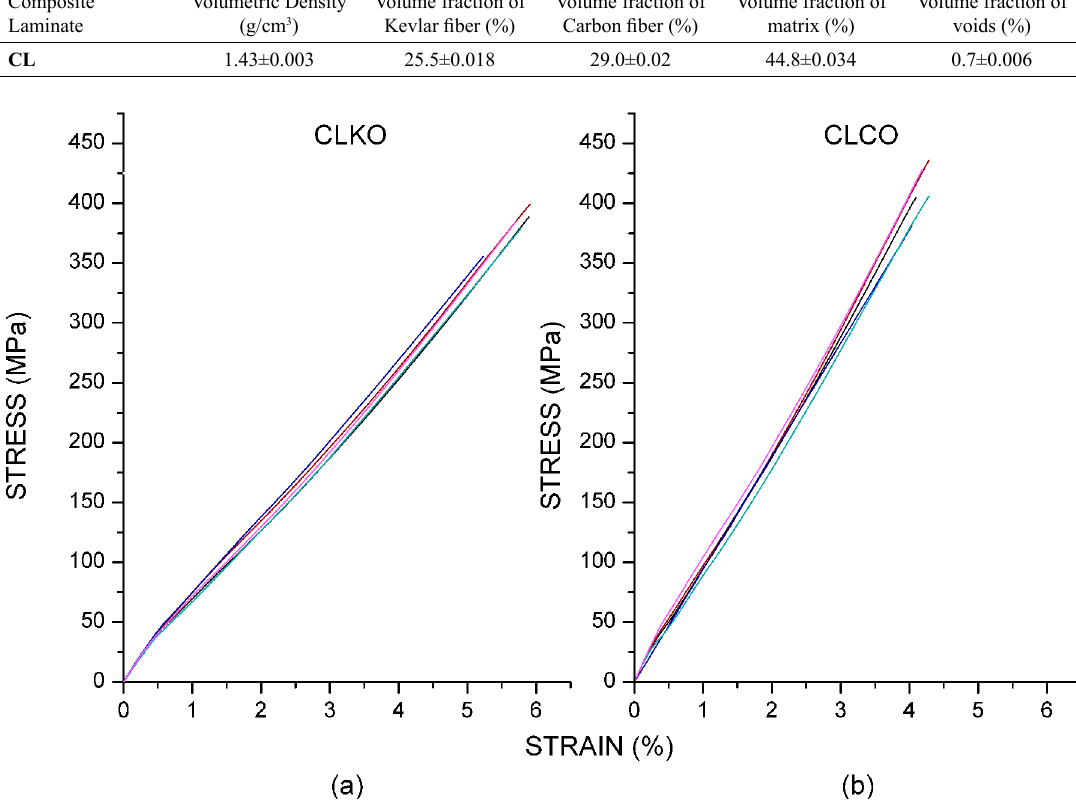
Table 1. Volumetric density and constituent content of the composite laminate. Composite Laminate